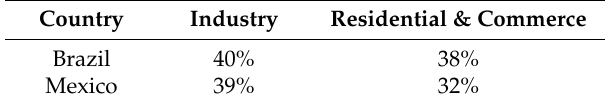
Table 2. Reduction potential in final energy demand by 2050 considered in the E[R]